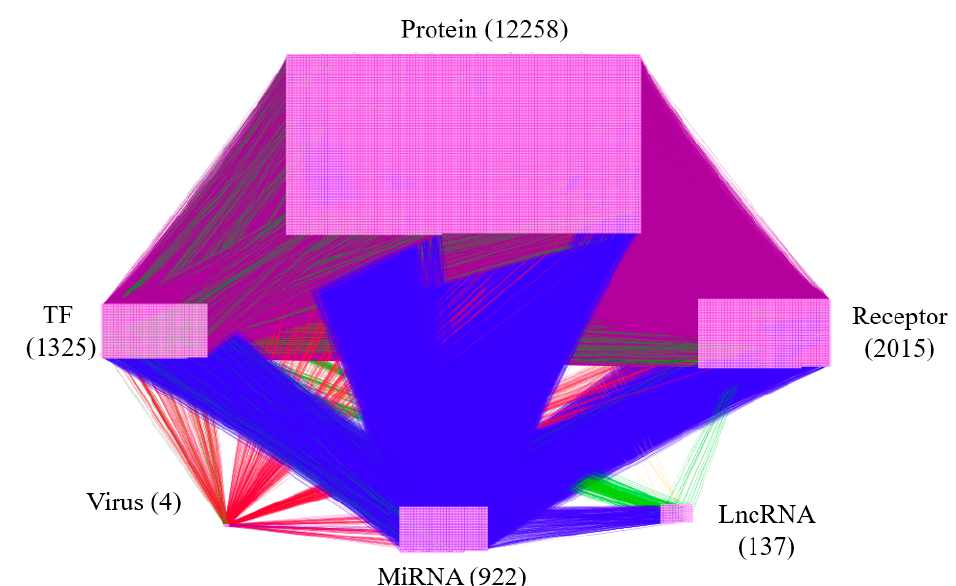
Figure 2. Real HPI-GEN between host and pathogen under infection of HBV. The real HPI-GEN describes the cross-talk interaction and regulation between host and pathogen after system identification analysis to prune false positives from candidate HPI-GEN. The purple lines denote PPIs; the green, yellow, blue, and red lines indicate the regulations by Transcriptional factors (TFs), lncRNAs, miRNAs, and Virus proteins respectively; and the total numbers of lncRNAs, miRNAs, proteins, receptors, Virus proteins, and TFs in the network are 137, 922, 12,258, 2015, 4, 1325, respectively.